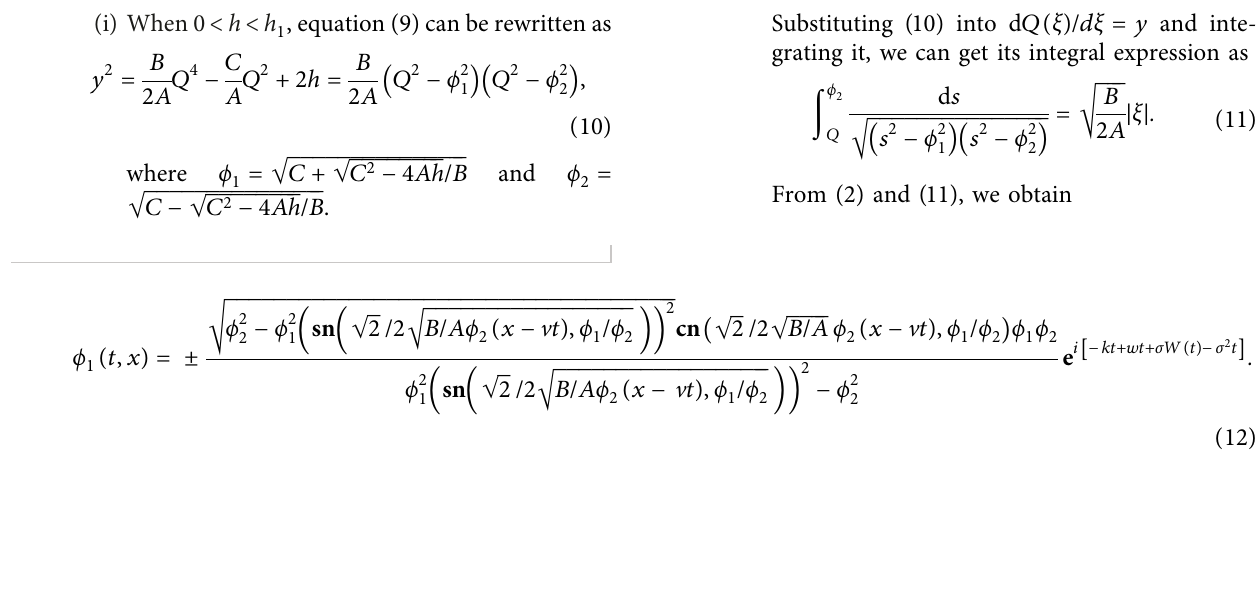
2, B 1, C 2. (c) A (cid:29)− (cid:29) (cid:29)